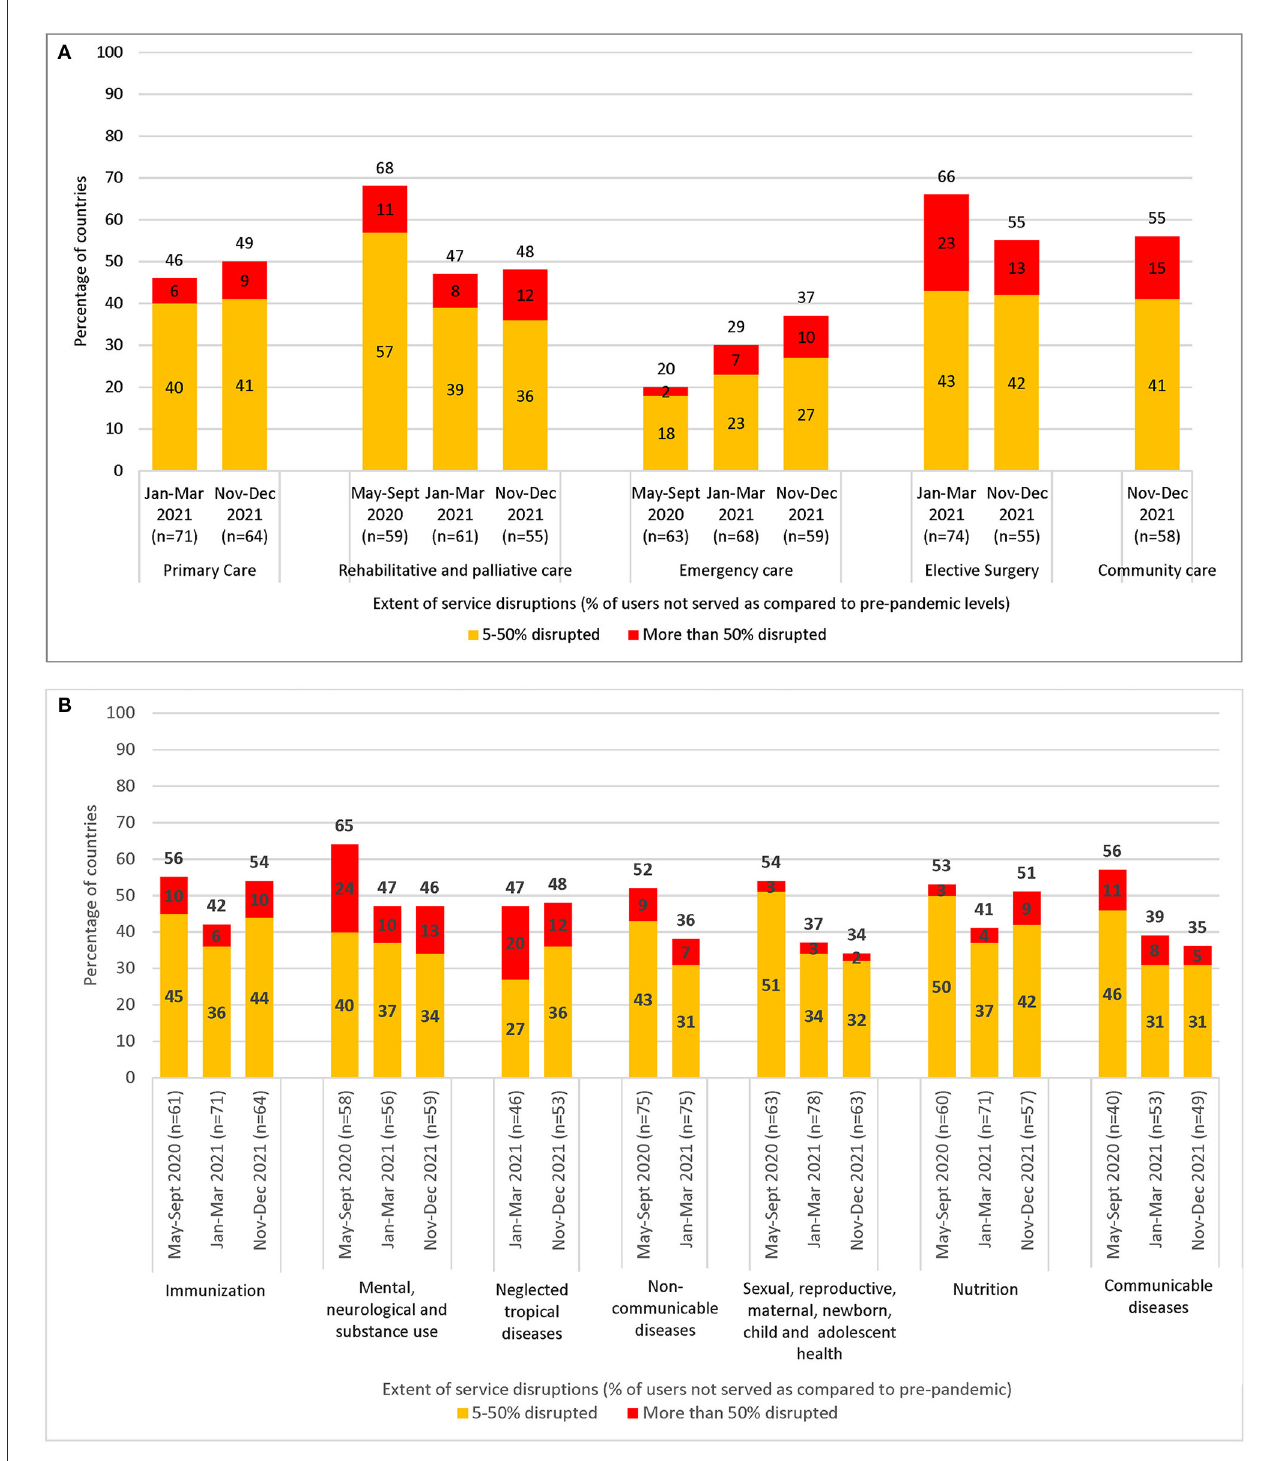
FIGURE1 (A) Comparison of disruptions by service delivery setting in 97 countries responding to all three WHO pulse survey rounds: May–September 2020 (round 1), January–March 2021 (round 2), and November–December 2021 (round 3). Primary care services and elective surgeries were not included in me first